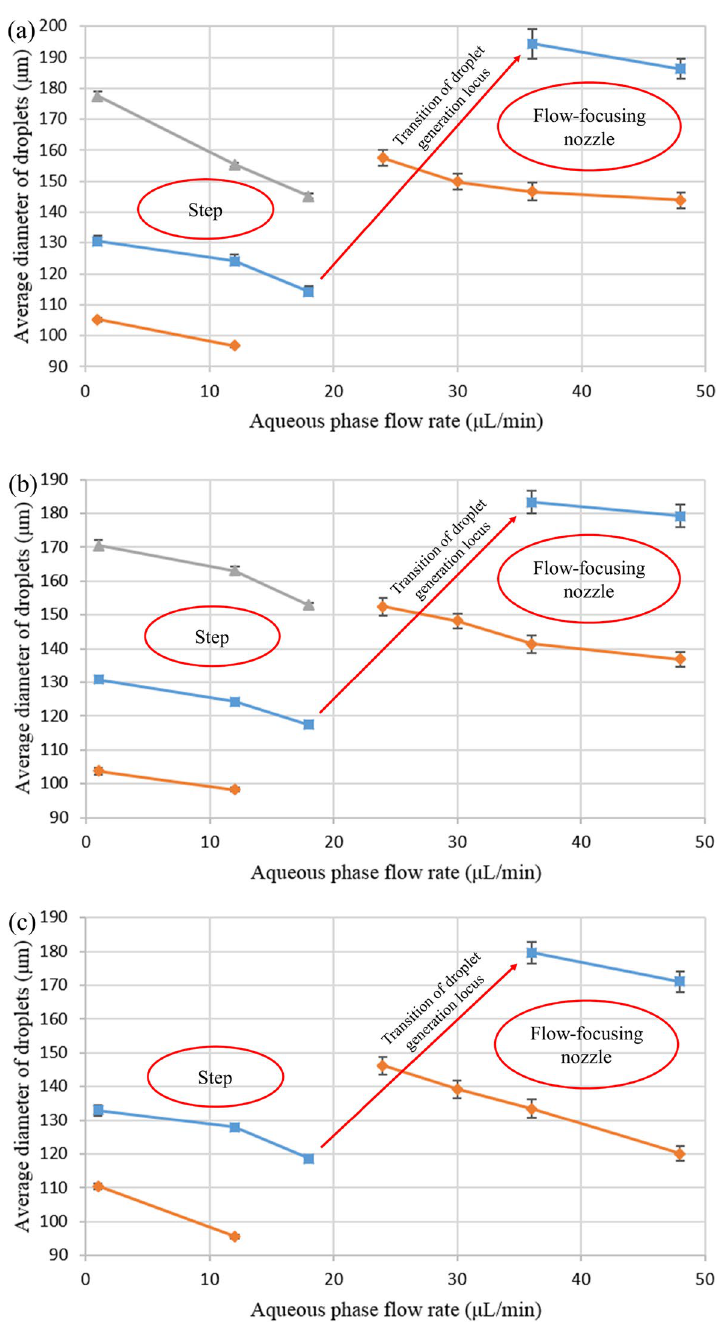
Figure 3. Average diameter of generated droplets versus flow rate of aqueous phase. α: ■ = 1, ♦ = 2.25, and ▲ = 0.44. ( a ) Q c = 6 μL/min. ( b ) Q c = 30 μL/min. ( c ) Q c = 60 μL/min. Error bars indicate standard deviation for average diameter of droplets (n =